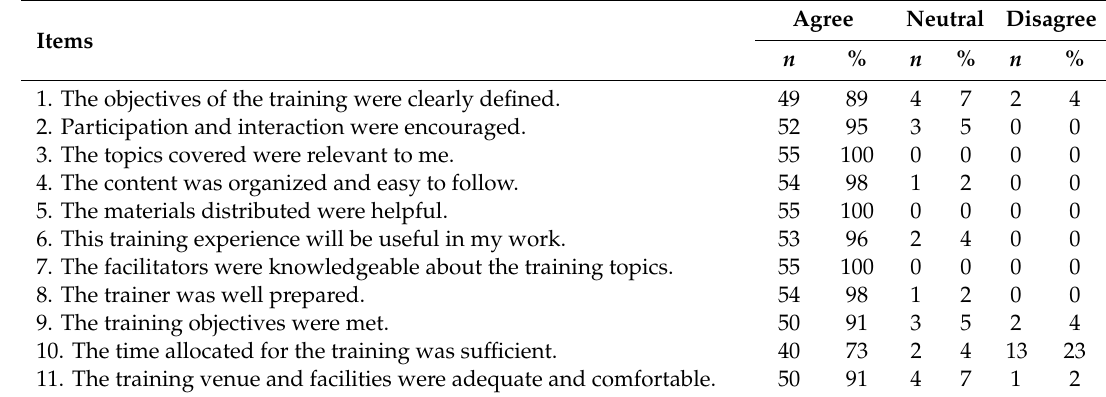
Table 1. A training evaluation tool.